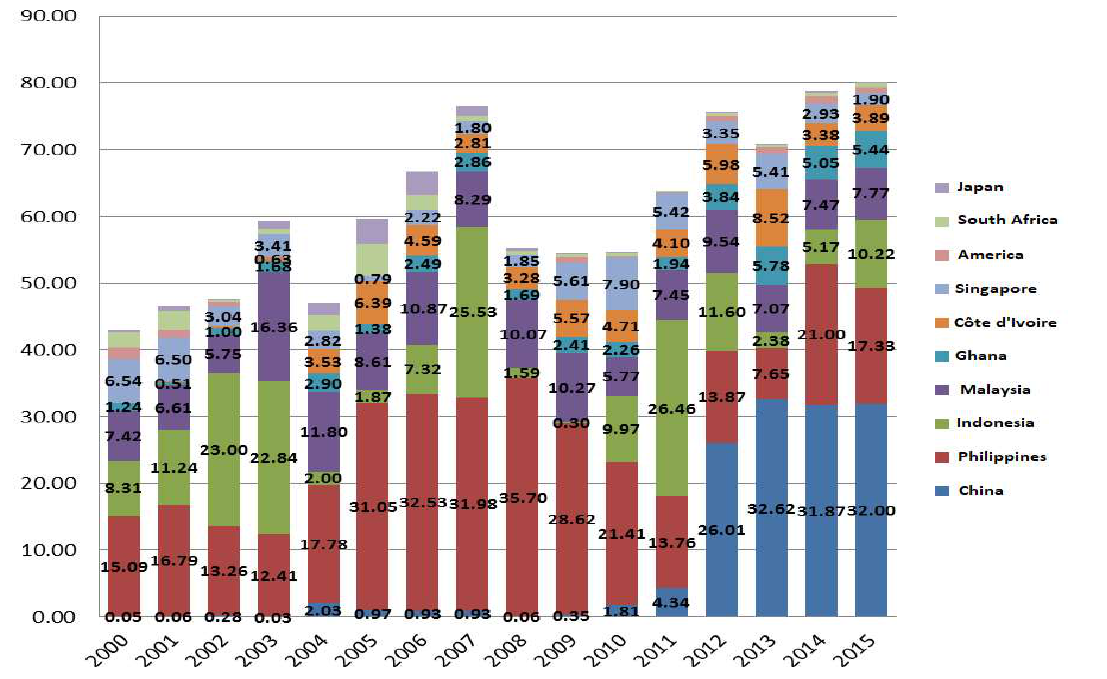
Figure 2. Structure of Vietnam's rice export market (% compared to total